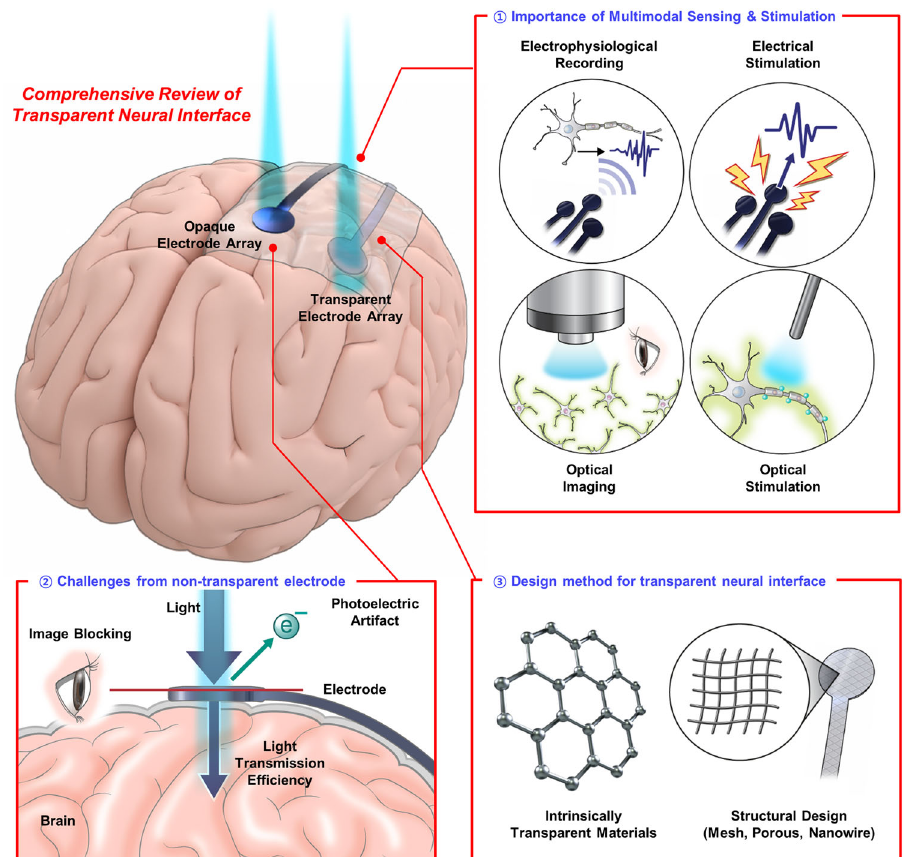
Fig. 1 A schematic introduction of the comprehensive review of the transparent neural interface. Schematic illustration of issues with transparent neural interface. (1) Importance of multimodal sensing & stimulation, (2) Challenges from non-transparent electrode, (3) Design method for transparent neural